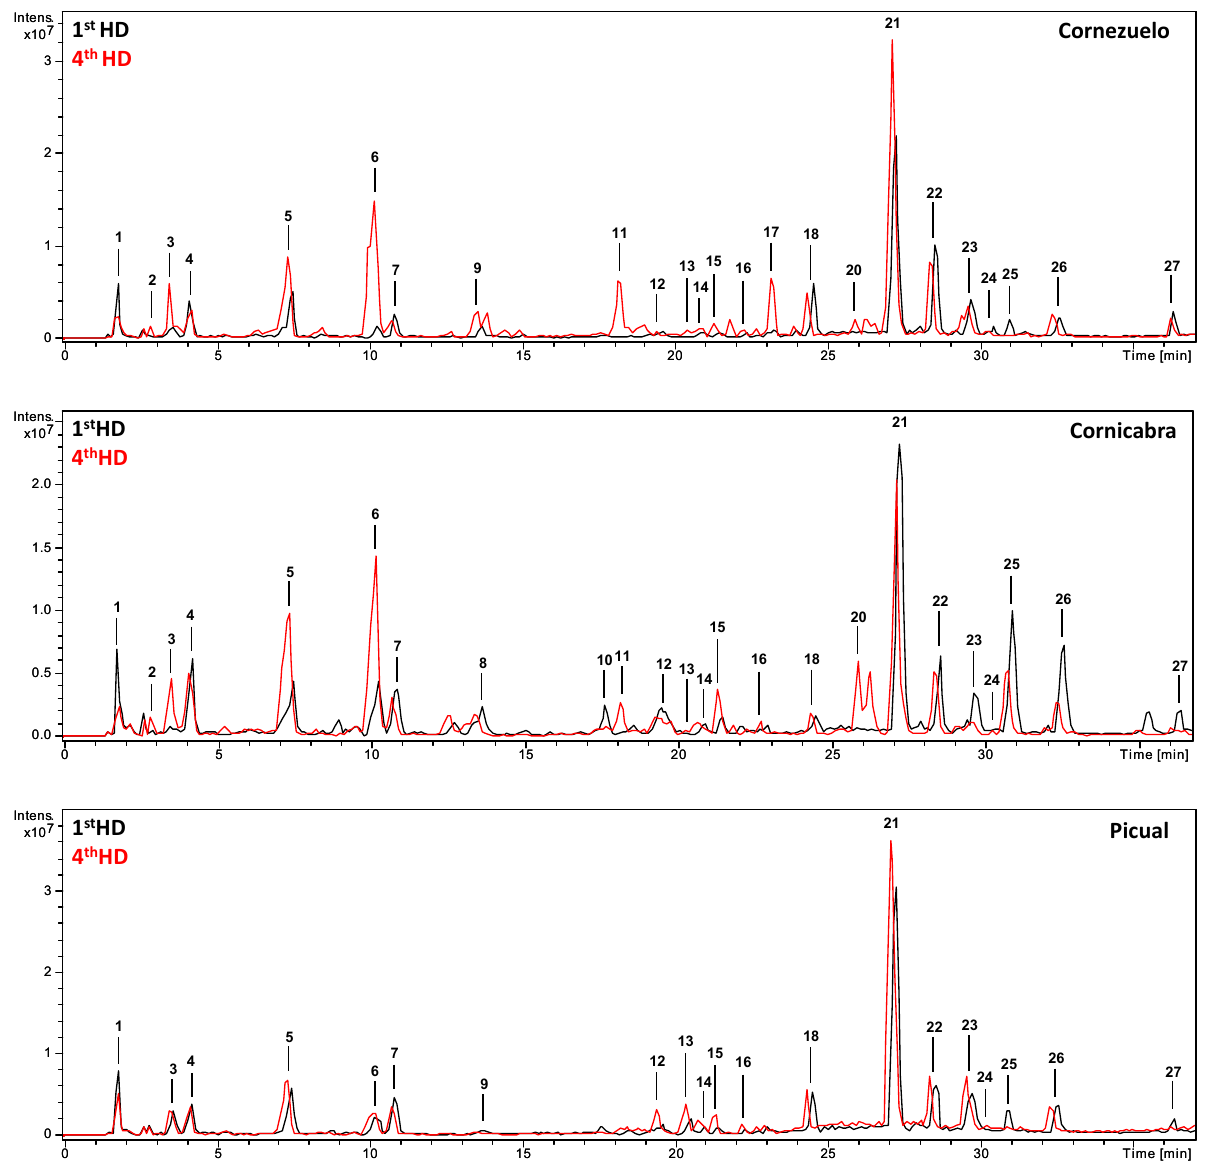
Figure 1. HPLC-ESI/MS n base peak chromatograms (BPC) of the extracts of Cornezuelo, Cornicabra and Picual olives for 2018/2019 season in 4 th HD.